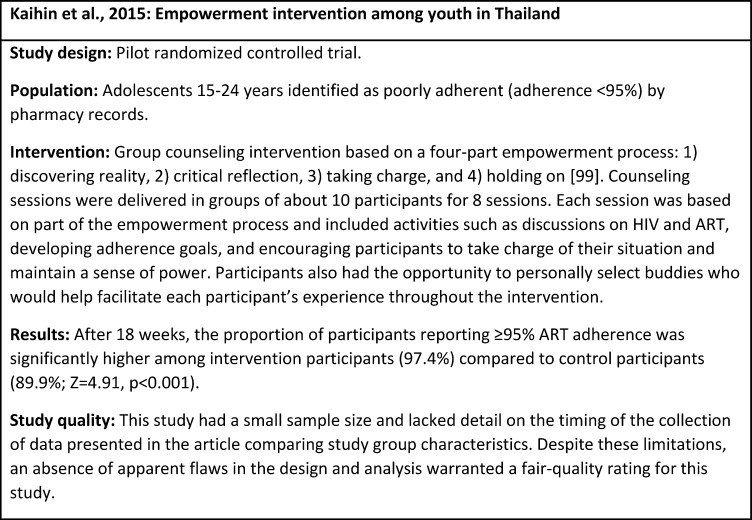
Kaihin et al., 2015.